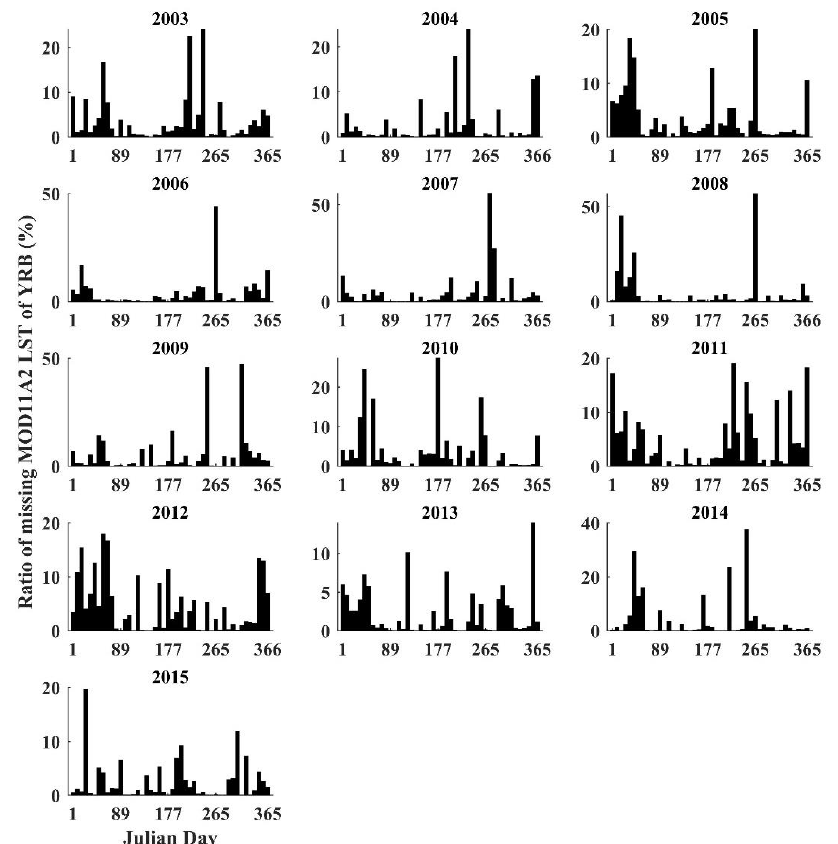
Figure A7. The ratio of the missing values in the YRB sites during the years 2003–2015. In the original files of MODIS land surface temperature product of MOD11A2 and MYD11A2, some of the pixel values are filling values, which are not within the valid range. In other words, these values are missing values. The ratio of missing values is the ratio of the area containing all missing value pixels to the total area of the YRB. Remote Sens. 2020 , 12 , x FOR PEER REVIEW 24 of 31